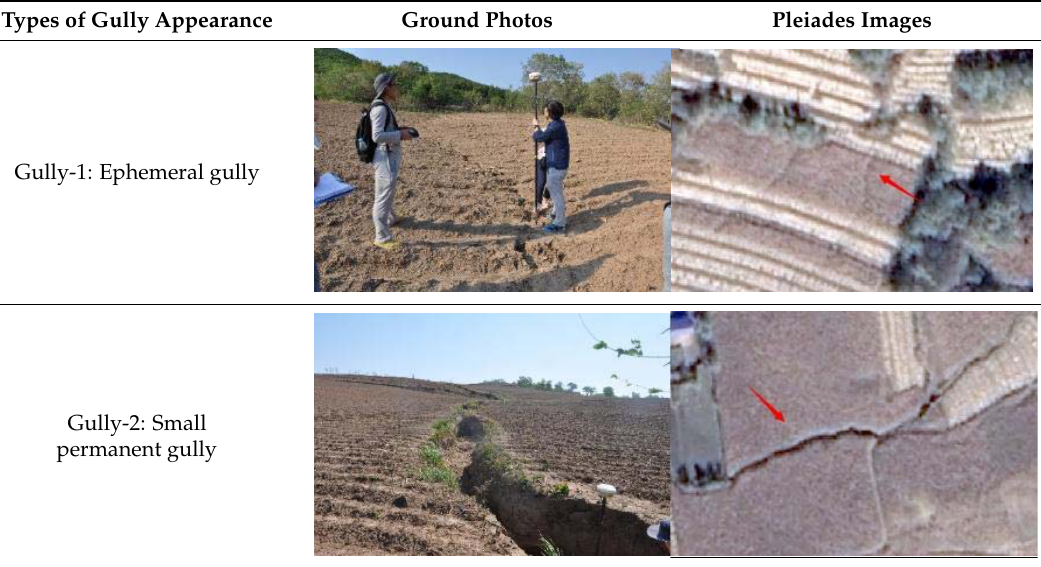
Table 1. Interpretation signs: four types of gully appearance in the high-resolution satellite images and ground photographs of the study area.